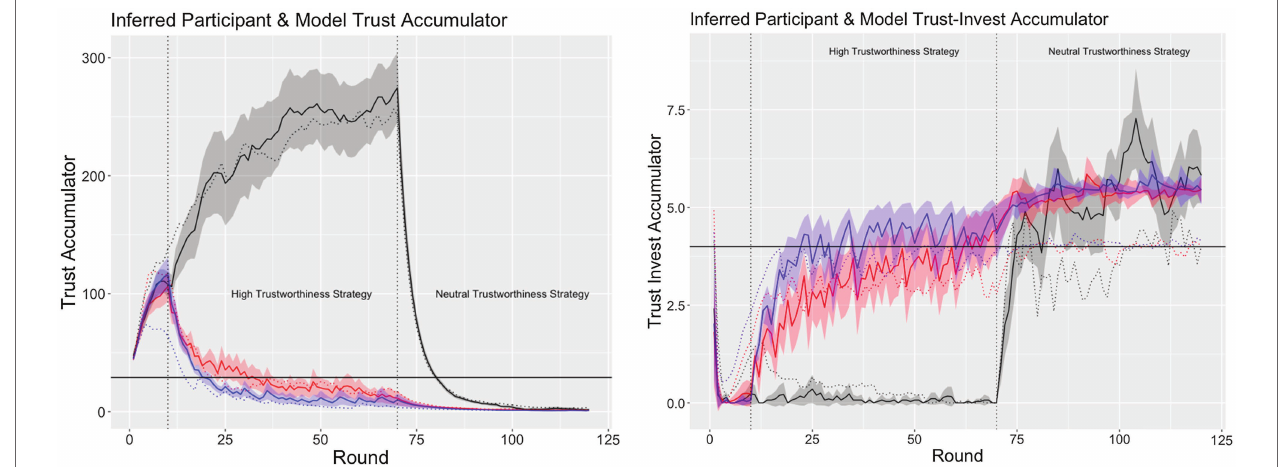
FIGURE 6 | The average ±95% CI inferred trust (left plot) and trust-invest (right plot) in the high (solid black line), medium (solid redline), and low (solid blue line) interaction condition and the average model trust and trust-invest values for high (dashed black line), medium (dashed red line), and low (dashed blue line) interaction